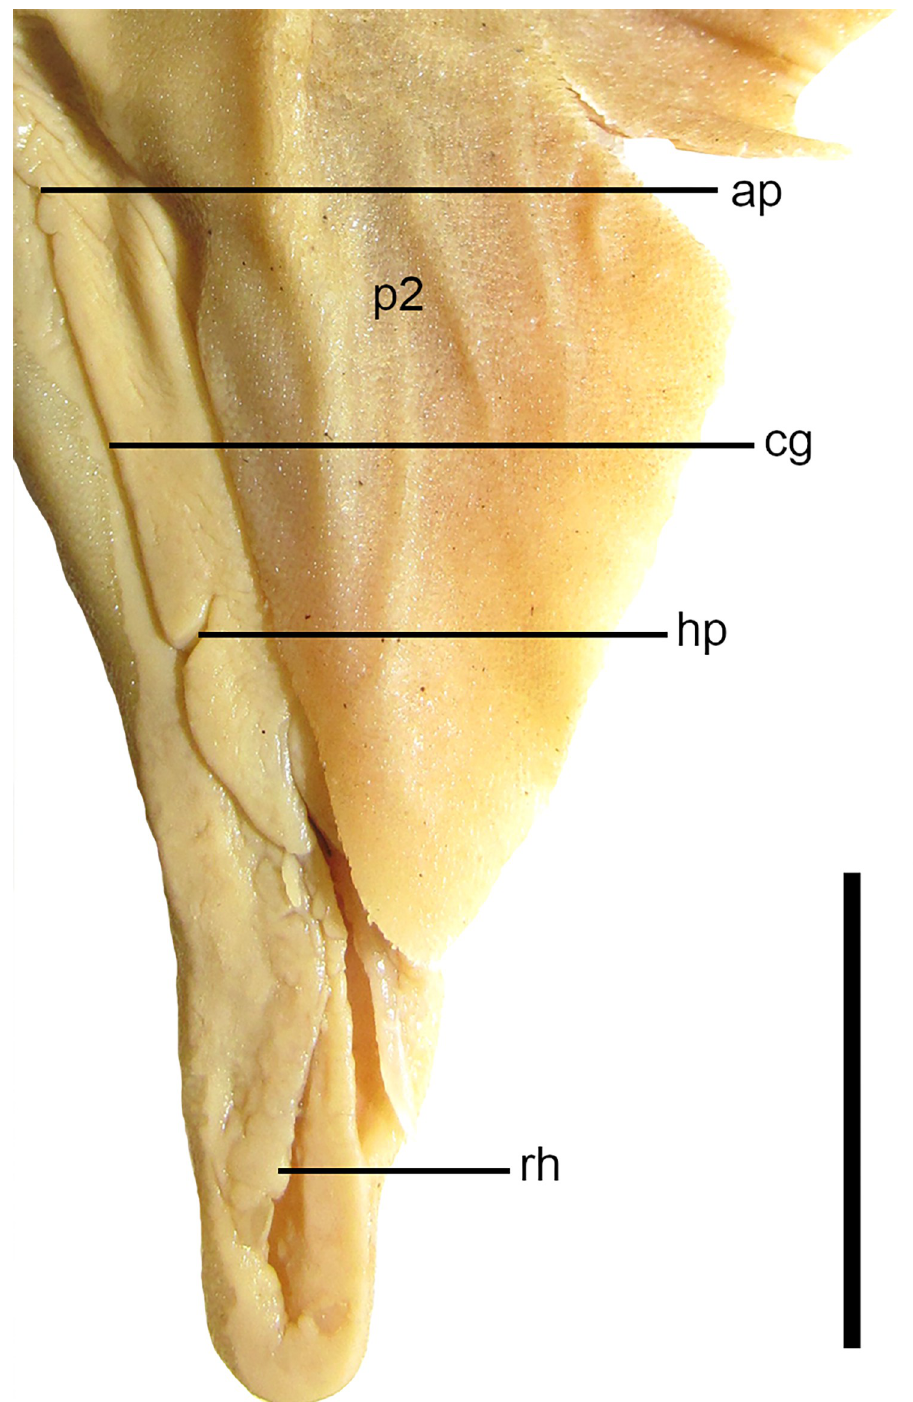
Fig 21. Specimens of C . asper in lateral view. A: BMNH 1972.10.10.1 (holotype), adult male, 880 mm TL, Seychelles; B: SAIAB 6092, juvenile female, 275 mm TL, South Africa; C: USNM 220585, juvenile male, 245 mm TL, the U.S.A. Scale bars: 50